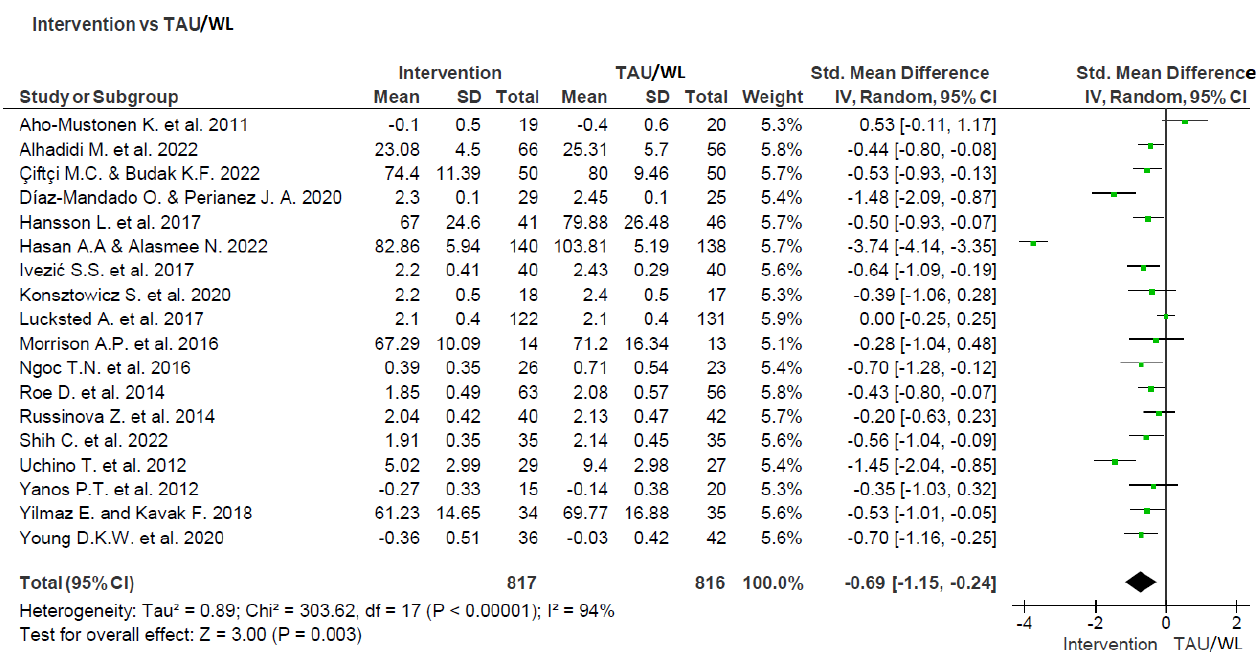
Figure 2. Meta-analysis and forest plot illustrating the efficacy of the overall interventions that were utilized in reducing internalized stigma in comparison to Treatment as Usual (TAU) or the Waiting List (WL)